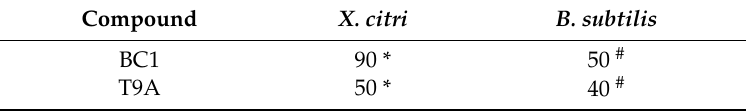
Table 1. Minimal inhibitory concentrations of the compounds ( μ g/mL).